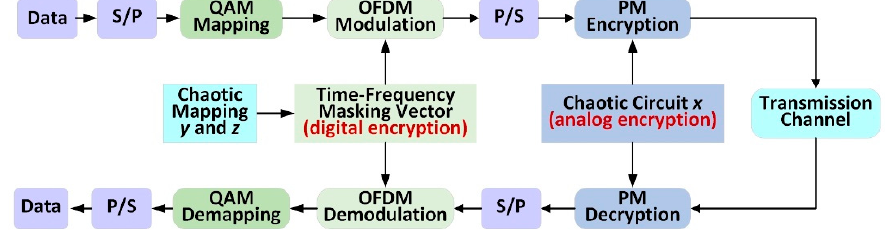
Figure 1. Schematic diagram of the proposed encryption scheme.